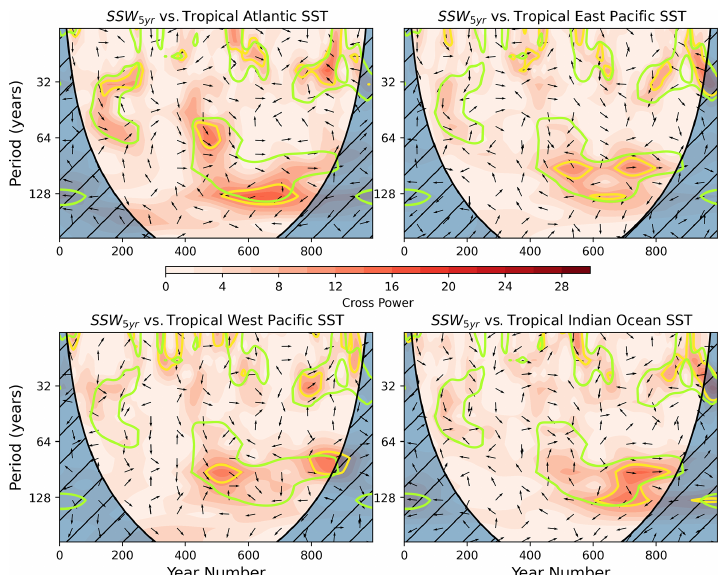
Figure A6. Cross-power spectra between September–November tropical SST anomaly time series and SSW 5 years . SST regions are defined as the tropical Atlantic (5 ◦ S–5 ◦ N, 60–0 ◦ W), tropical eastern Pacific (5 ◦ S–1 ◦ N, 160–270 ◦ E), tropical western Pacific (5 ◦ S–25 ◦ N,